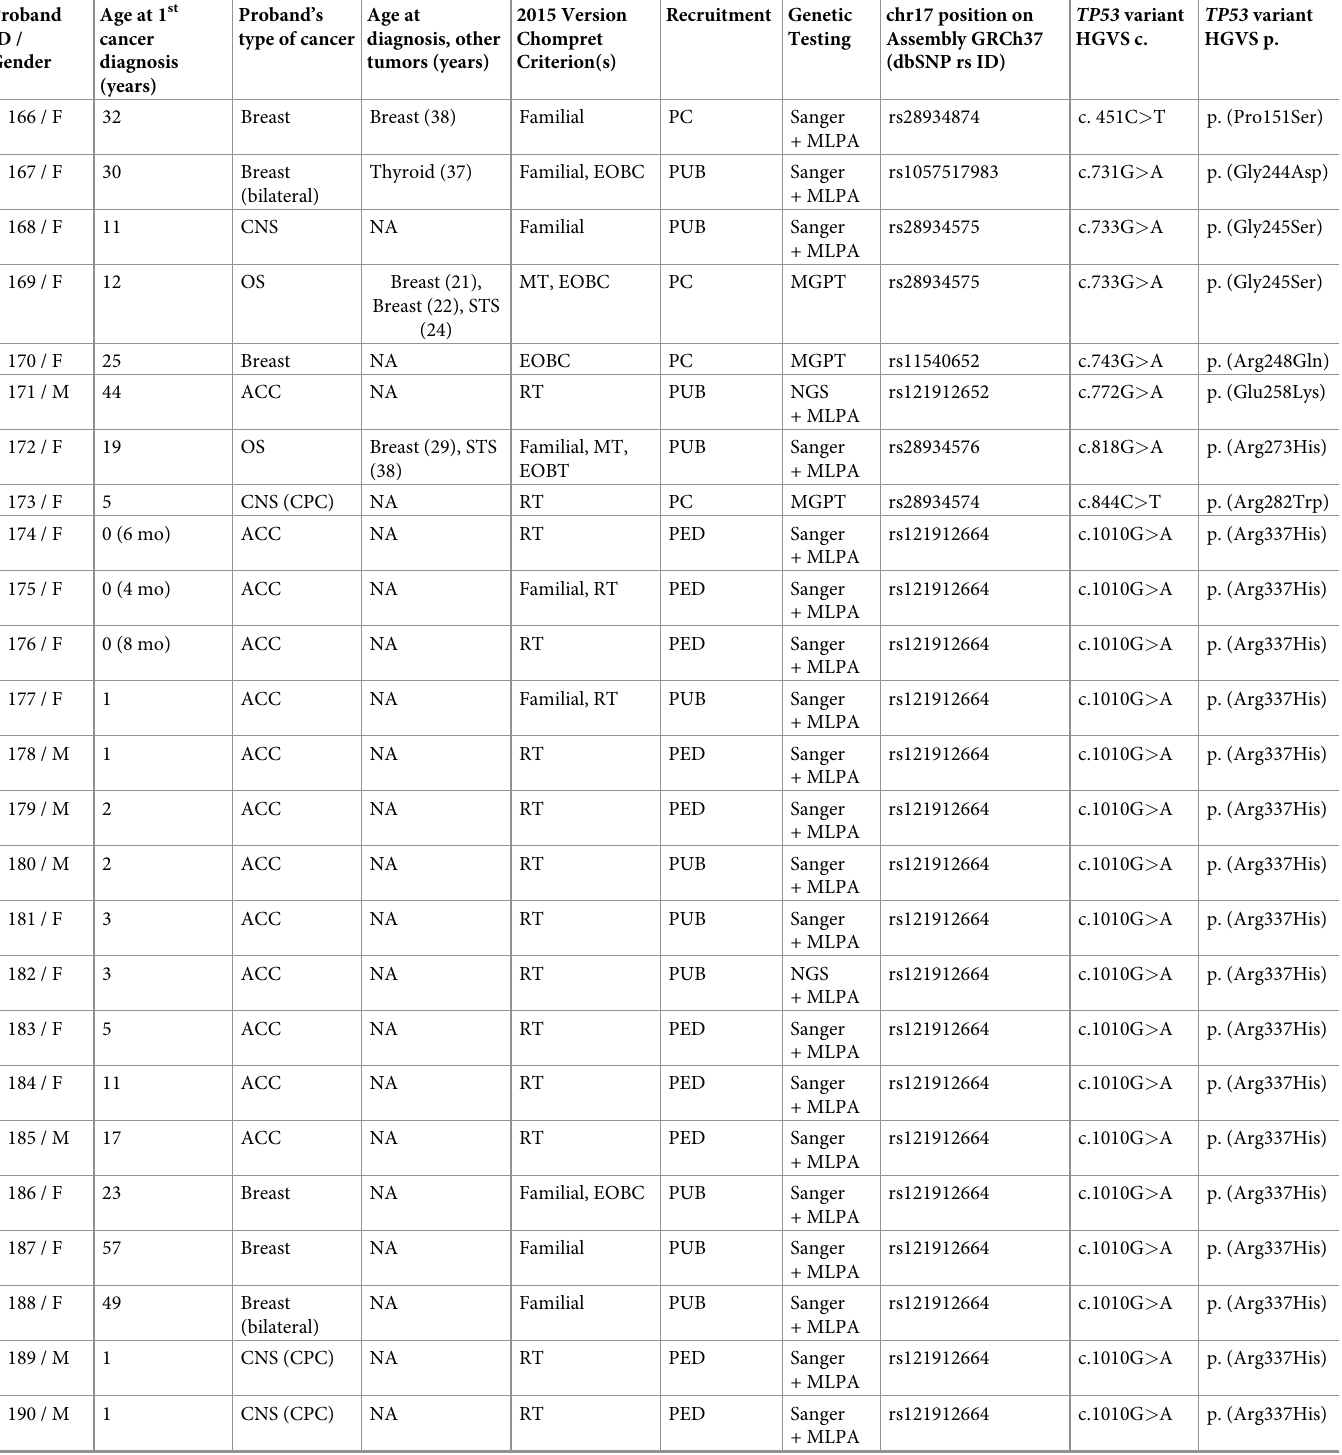
Table 1. Clinical and molecular characterization of all LFS probands harboring germline TP53 pathogenic variants (PV) identified in this